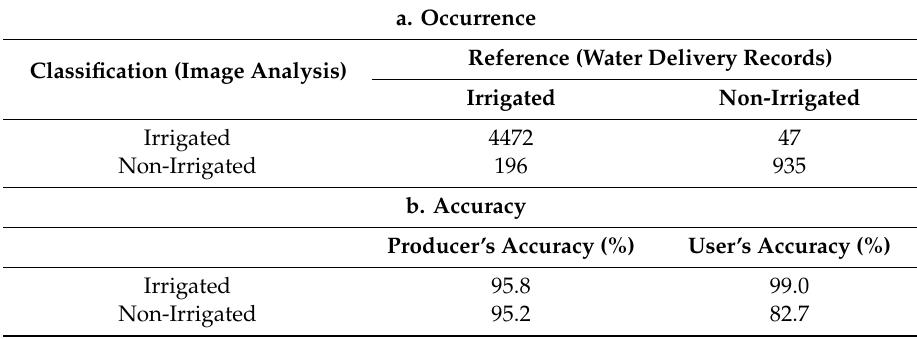
Table 3. Accuracy Assessment of the Irrigation